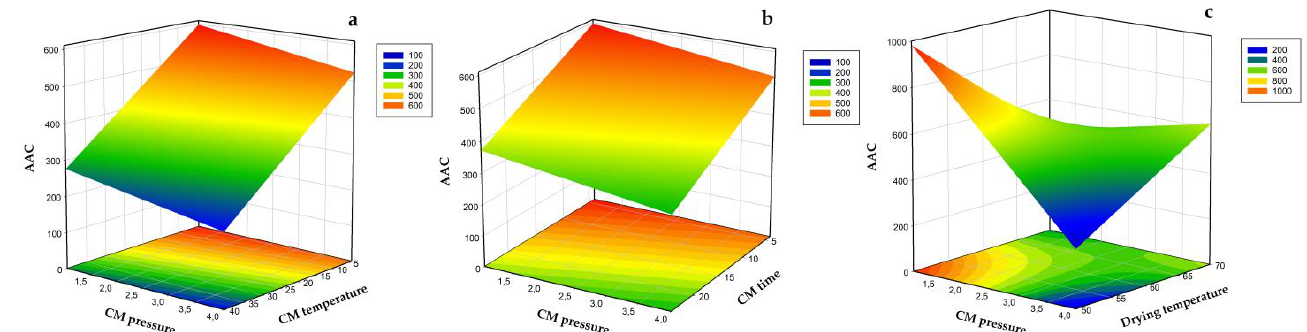
Figure 4. Influence of ( a ) CM pressure (bar) and CM temperature (°C), ( b ) CM pressure (bar) and CM time (h), and ( c ) CM pressure (bar) and drying temperature (°C) on AAC (mg AA/100 g DM) of dried strawberries with CM pre-treatment.